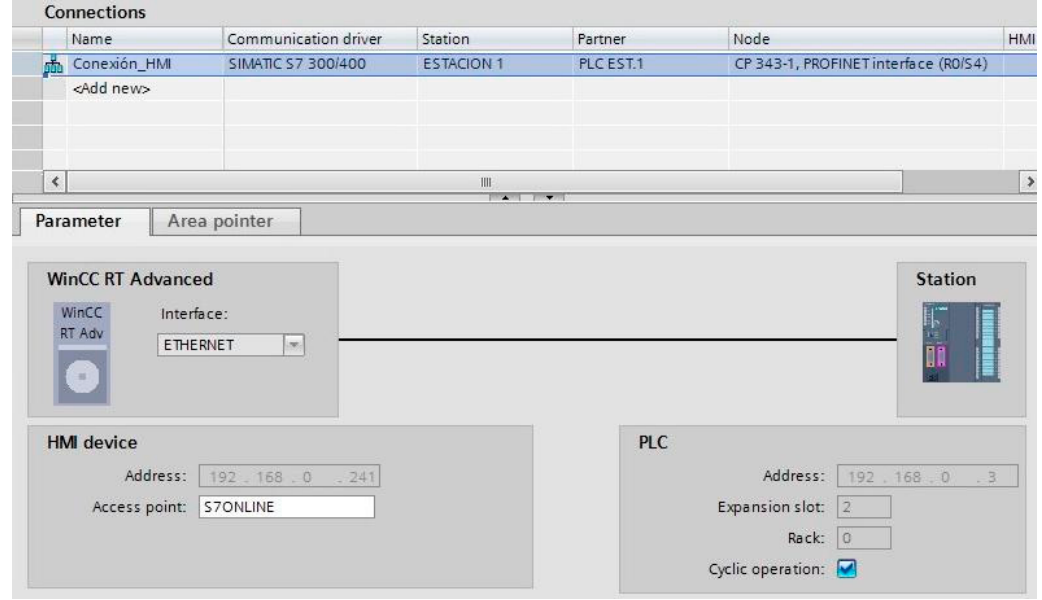
Figure 15. C onfiguration screen for the SCADA connection. Figure 15. Configuration screen for the SCADA